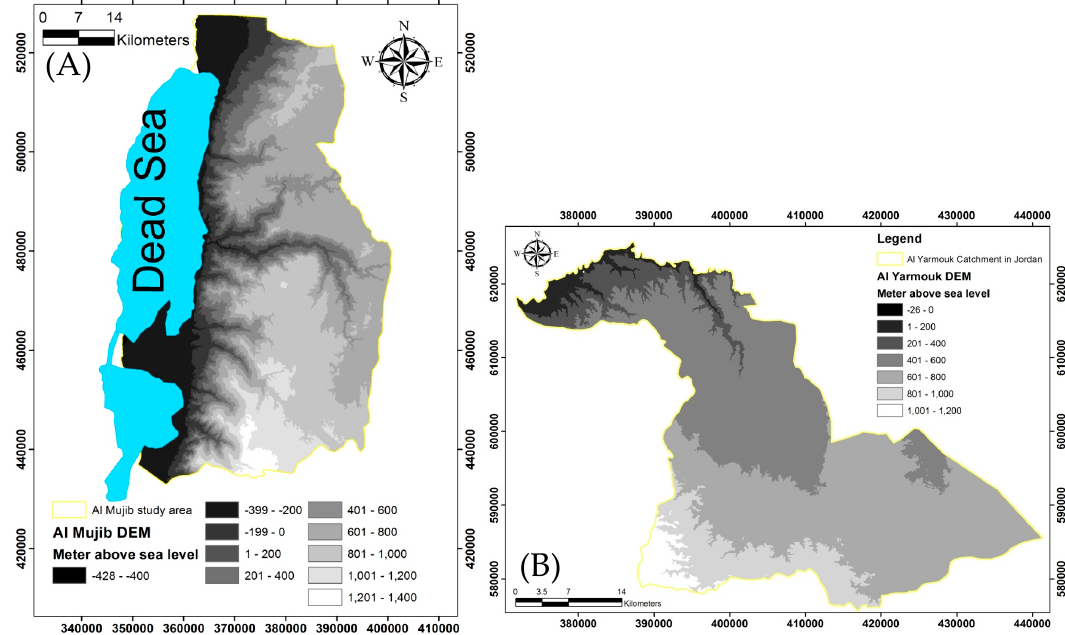
Figure 2. The high relief topography of the studied areas. ( A ) is the Mujib study area where the topography of the study area is effected mainly by the faults of the Dead Sea transform fault (a regional fault). ( B ) is the Yarmouk study area where the topography has effected mainly rock erosion, especially the sinkholes of limestone rocks.